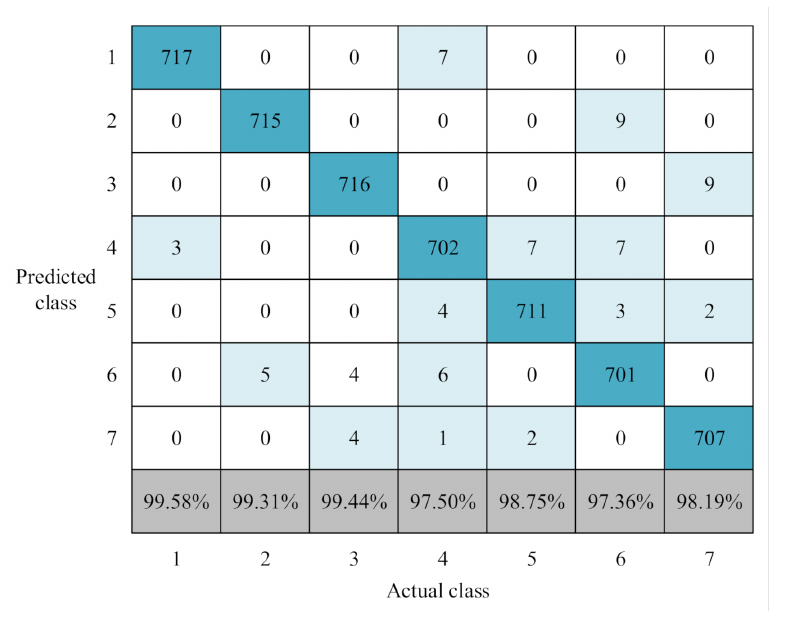
Figure 11. Fault diagnosis result with ideal data based on the